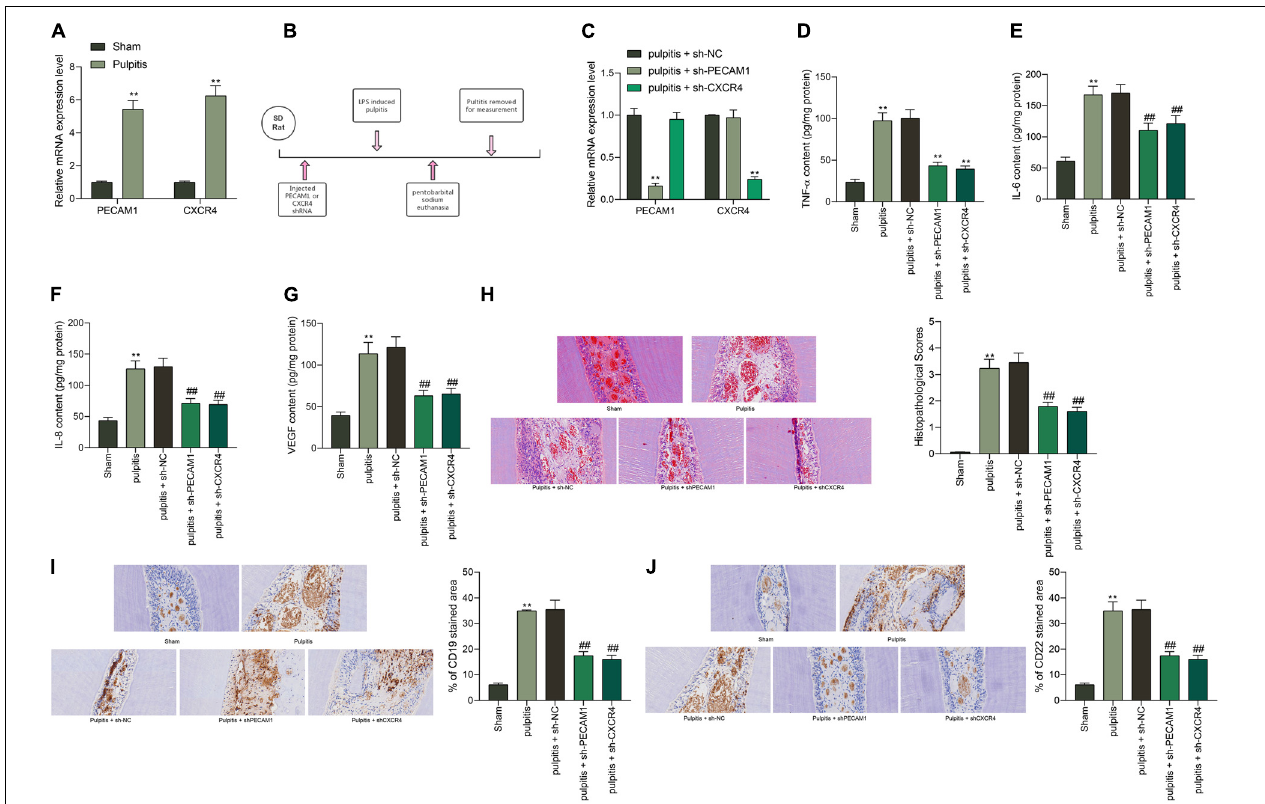
FIGURE 2 | Knockdown of PECAM1 or CXCR4 alleviates pulpitis in mice. (A) Expression of PECAM1 and CXCR4 in dental pulp tissues determined by RT-qPCR. (B) a diagram presentation of rat treatment: after 1 week of acclimatization, shRNAs of PECAM1 and CXCR1 were injected into the left-side dental pulp tissues of rats. After 48 h, a rat model with pulpitis was induced using LPS. The serum samples were collected 24 h later to examine the expression of inflammatory cytokines in serum. Next, the rats were euthanized through intraperitoneal injection of 150 mg/kg pentobarbital sodium, and then the dental pulp tissues were collected for further use. (C) mRNA expression of PECAM1 and CXCR4 in rat dental pulp tissues examined by RT-qPCR. (D–G) expression of inflammatory cytokines TNF- α , IL-6, IL-8, and VEGF in rat serum determined by ELISA kits. (H) Pathological changes in rat dental pulp tissues observed by HE staining. (I,J) Expression of B-cell-specific protein markers CD19 and CD22 in rat dental pulp tissues determined by IHC staining. In each group, n = 6. Data were collected from three individual experiments and expressed as mean ± SD. Data were analyzed by one-way (D–J) or two-way (A,C) ANOVA followed by Tukey’s multiple comparison test. ** p < 0.01 vs. sham group; ## p < 0.01 vs pulpitis + sh-NC